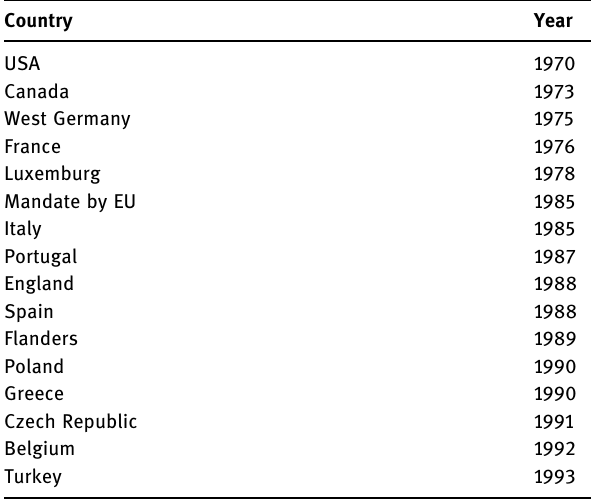
Table 1: Years when EIA regulation was enacted in some coun